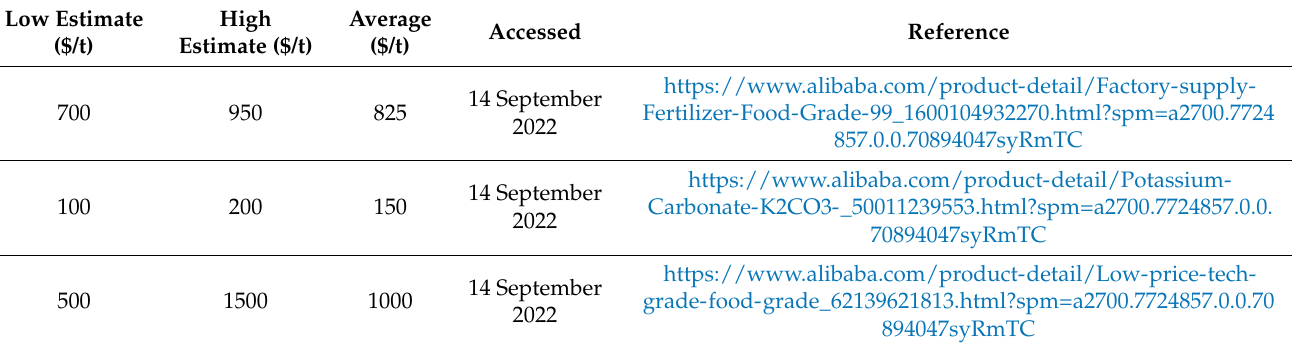
Table A2. Bulk Vendor Costs for K 2 CO 3 .